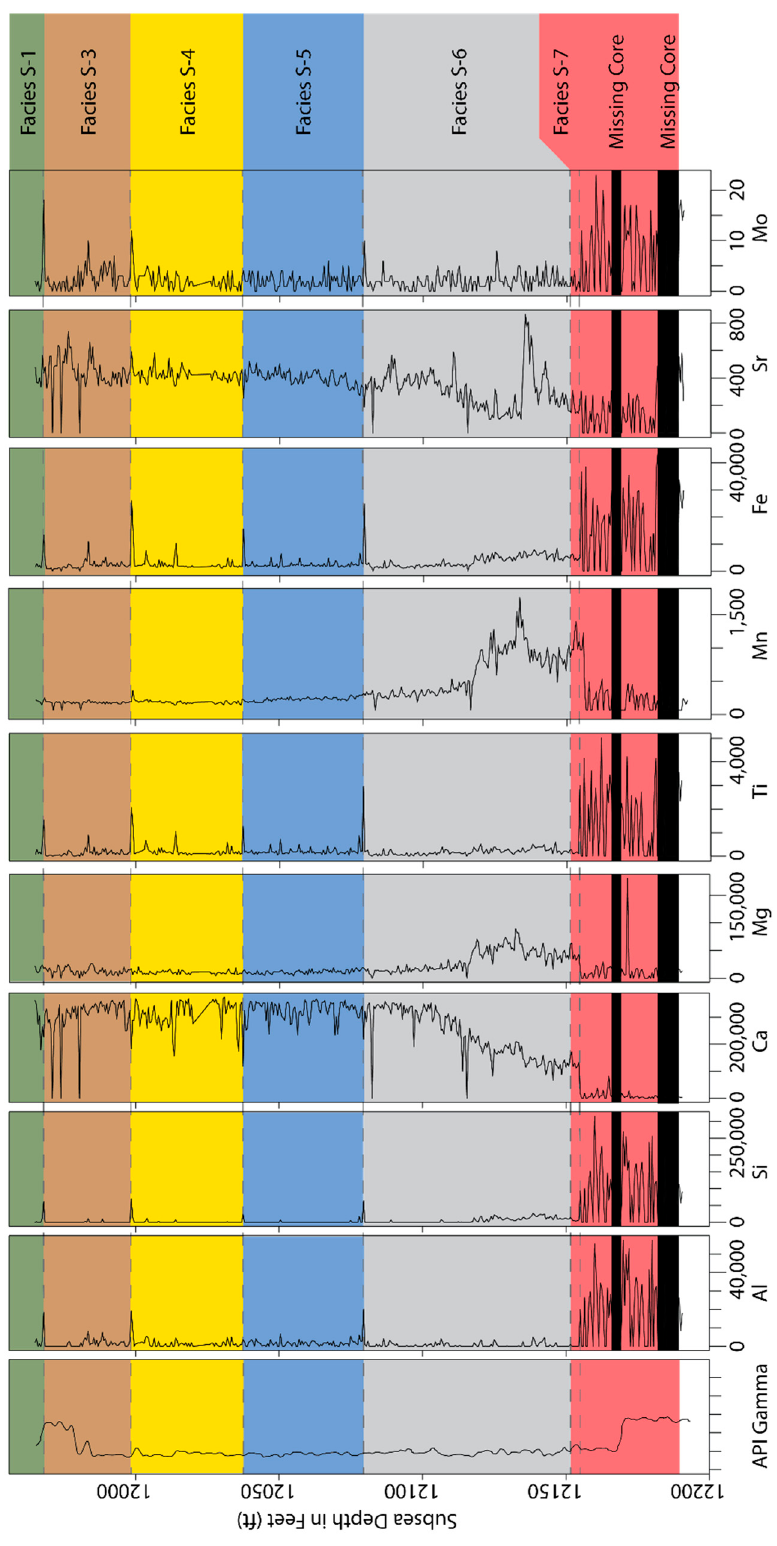
Figure 5. Cedar Creek Land and Timber 33-10 #1 elemental log generated from selected XRF data with defined lithofacies. All elemental values are reported in parts per million (mg/kg).